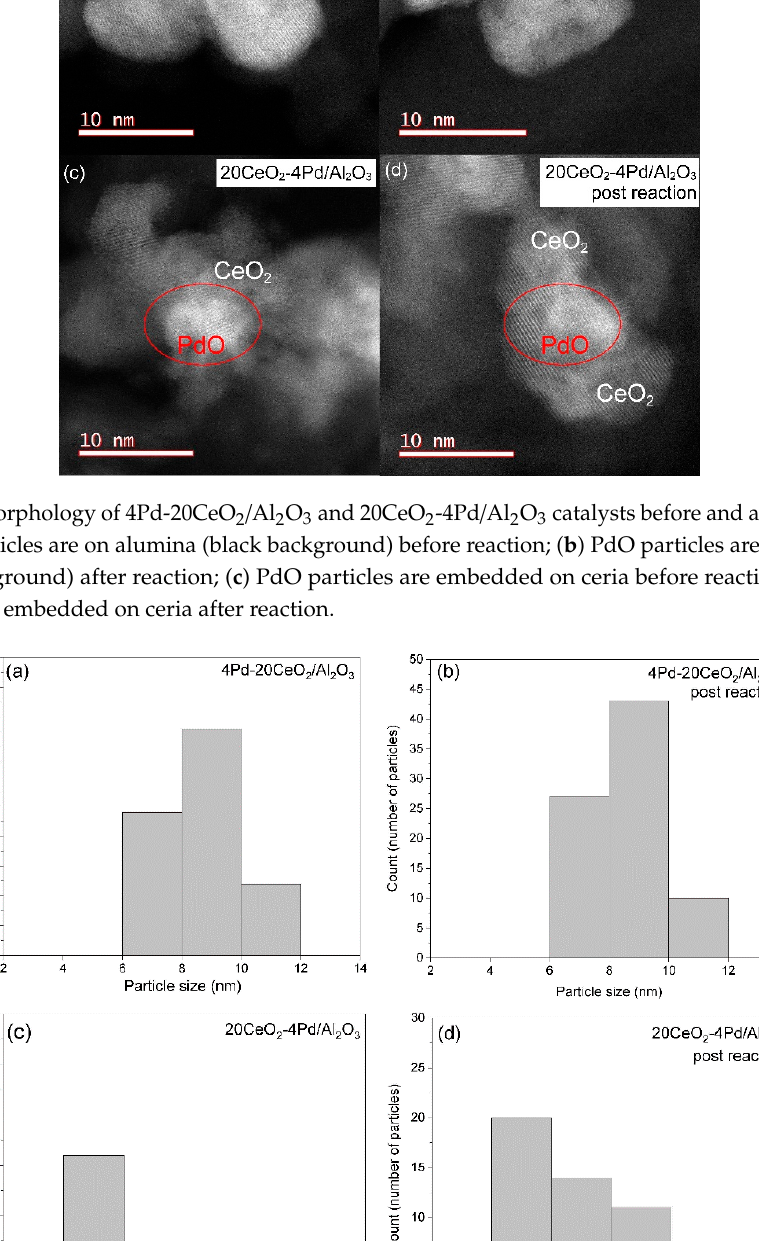
Figure 9. Particle size distributions. ( a ) PdO particle size distribution in 4Pd-20CeO 2 / Al 2 O 3 before reaction; ( b ) PdO particle size distribution in 4Pd-20CeO 2 / Al 2 O 3 after reaction; ( c ) PdO particle size distribution in 20CeO 2 -4Pd / Al 2 O 3 before reaction; ( d ) PdO particle size distribution in 20CeO 2 -4Pd / Al 2 O 3 after reaction.